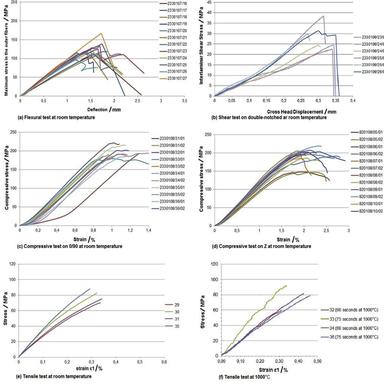
Stress strain curves for Cf-HfB2 powder composite.